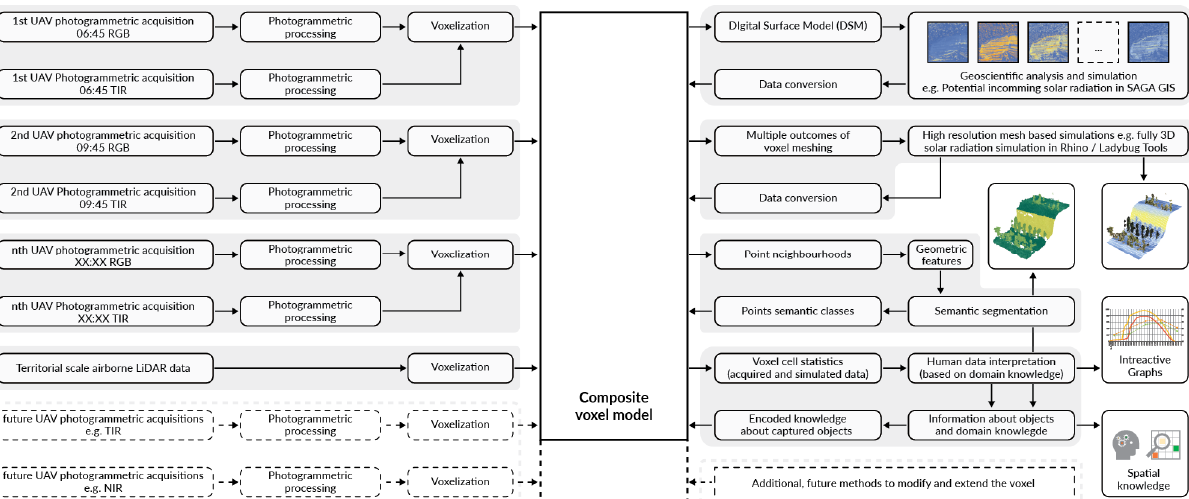
Figure 10. Workflow diagram presenting the steps needed to construct the CVM. Left: datasets used to construct the model. Right: interfaces with external simulation tools, as well as data processing and visualisation methods. Analysis and simulation results, such as incoming solar radiation, are fed back to the CVM, thereby creating feedback loops. This figure is available in Supplementary Materials (Figure S1) as a high-resolution, full page illustration.